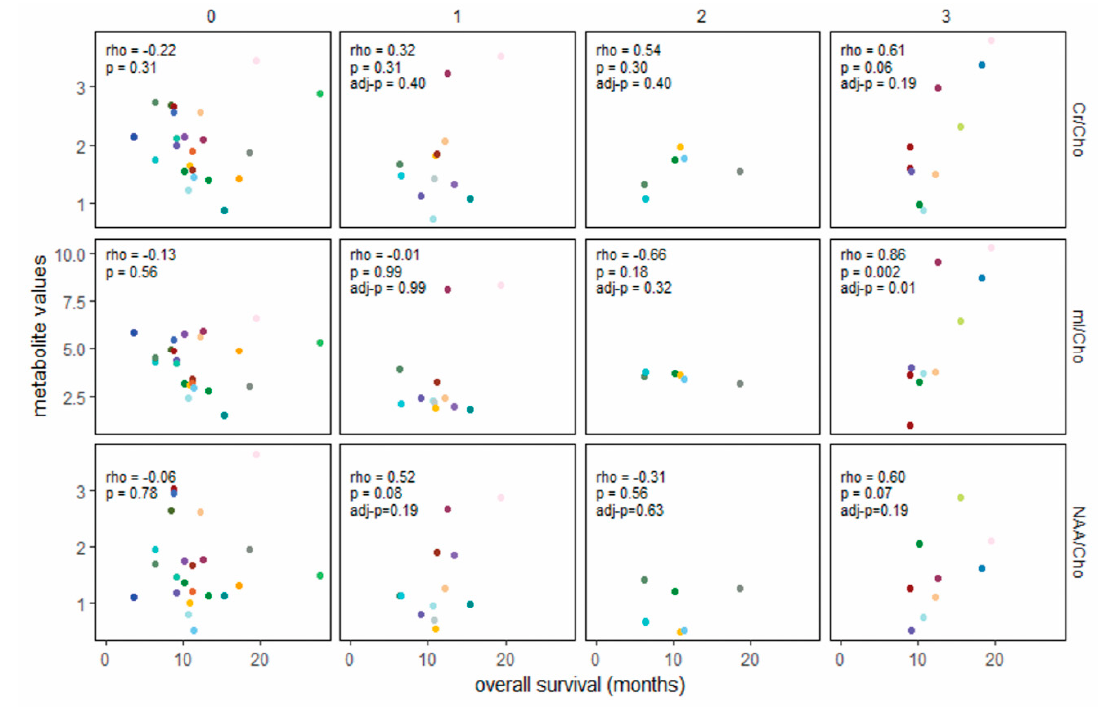
by timepoints relative to completion of RT (columns) (28 scans within 7.6 months of diagnosis in 12 patients). RT = irradiation with or without concurrent chemotherapy. Spearman rank-order correla- tions are shown for each panel, with Benjamini–Hochberg control of p -values to a false positive rate of 0.05 for all panels. Each color represents an individual patient. Timepoint 1 = post-RT and before vaccine therapy (1.9–3.8 months post-diagnosis); timepoint 2 = after 2–3 vaccine doses (3.9–5.2